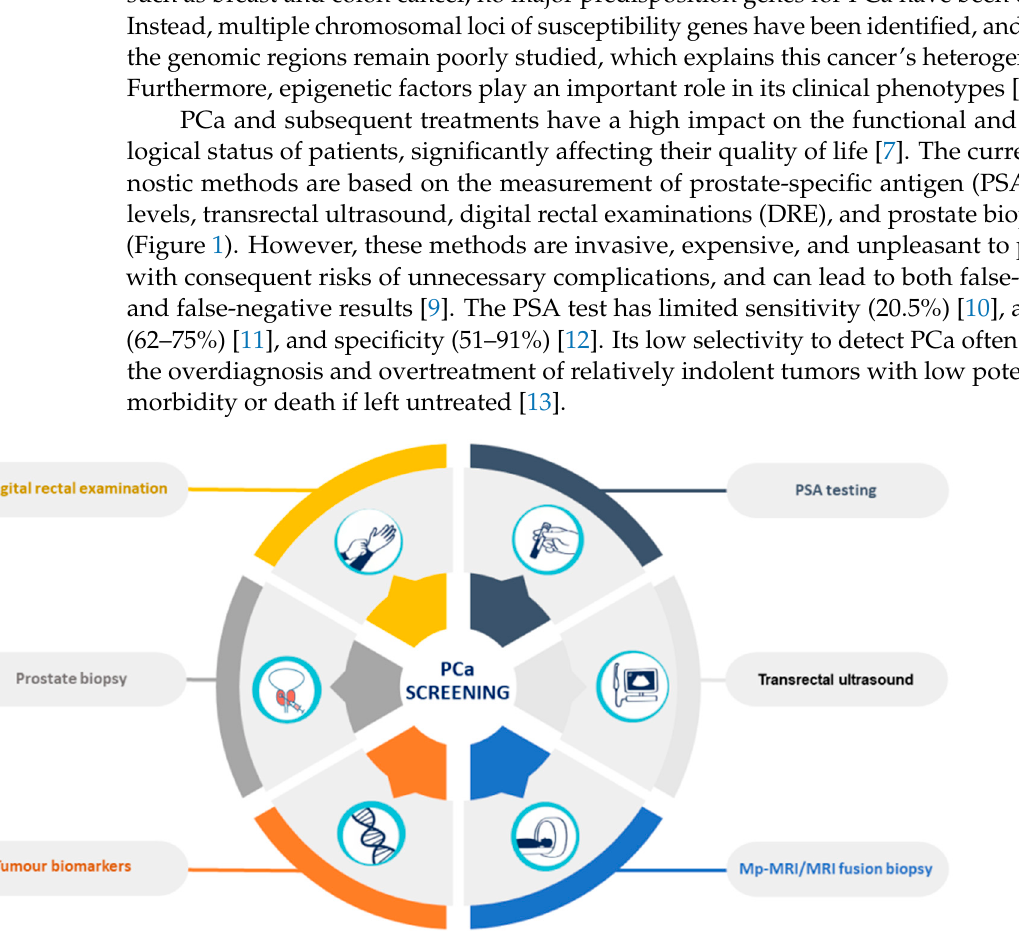
Figure 1. Prostate-cancer screening methods.